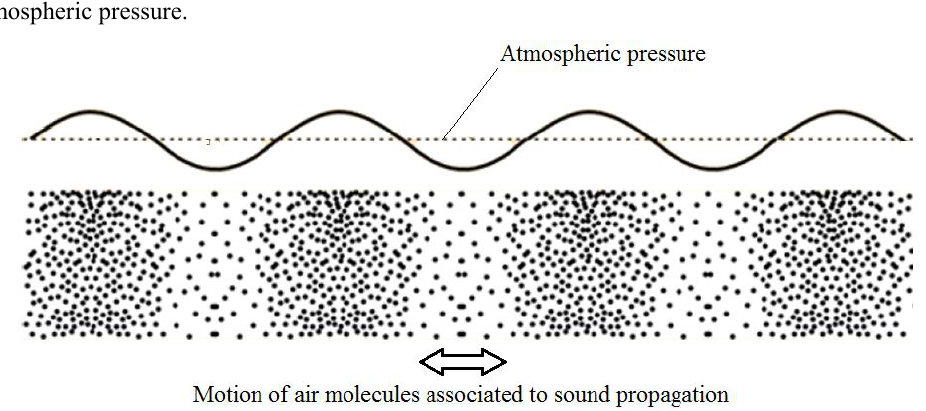
Fig. 1. Sound wave